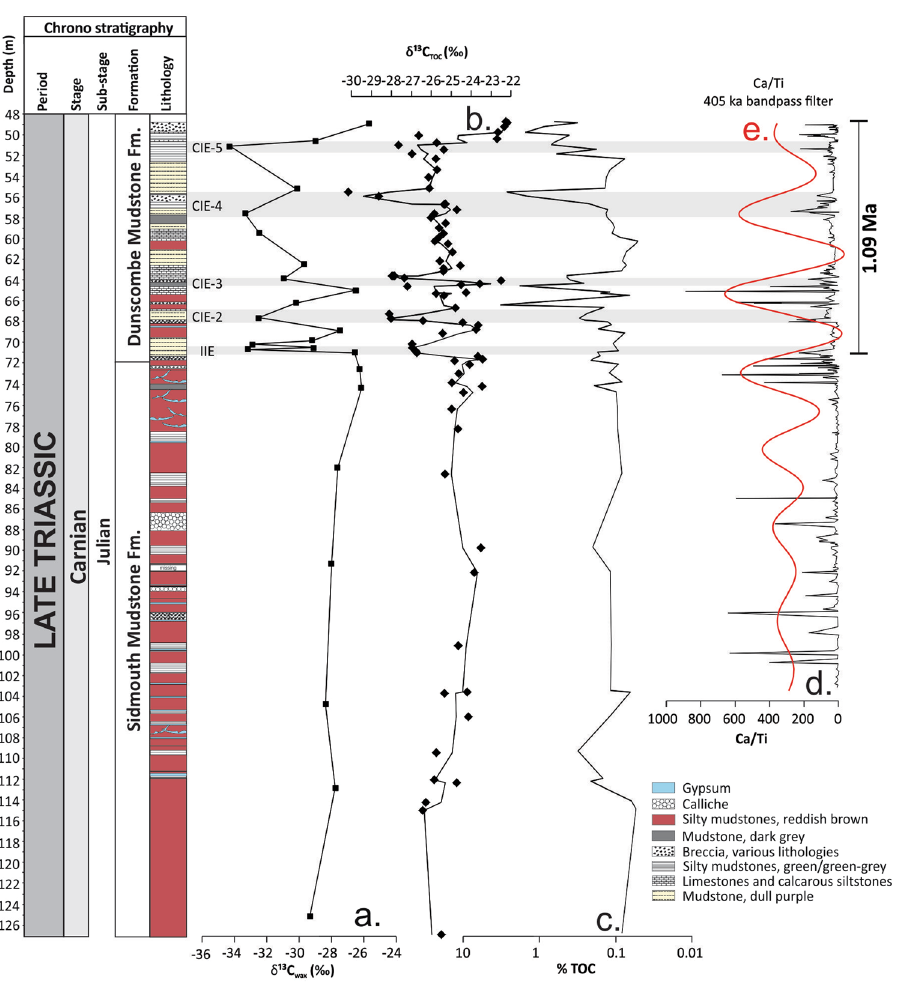
Figure 2. Environmental variability over the CPE from WP borehole 1. ( a ) Weighted mean of δ 13 C values for long chain n -alkanes (C 27 -C 35 ; δ 13 C wax ). ( b ) δ 13 C variations in bulk organic matter ( δ 13 C TOC ). ( c ) Percentage total organic carbon (TOC). ( d ) XRF Ca/Ti elemental abundance data. ( e ) 405 ka bandpass filter of the Ca/Ti XRF data. Note the dominant cyclicity present at c . 8 m, likely corresponding to the 405 ka eccentricity cycle (see also Fig. 3 and Fig. S6). The strength of the 405 ka eccentricity control on sedimentation decreases down core. The centre of the bandpass frequency is 0.13 m − 1 ( c . 8 m, c . 405 ka). Data filtering was carried out using a Gaussian filter in the R program Astrochron 43